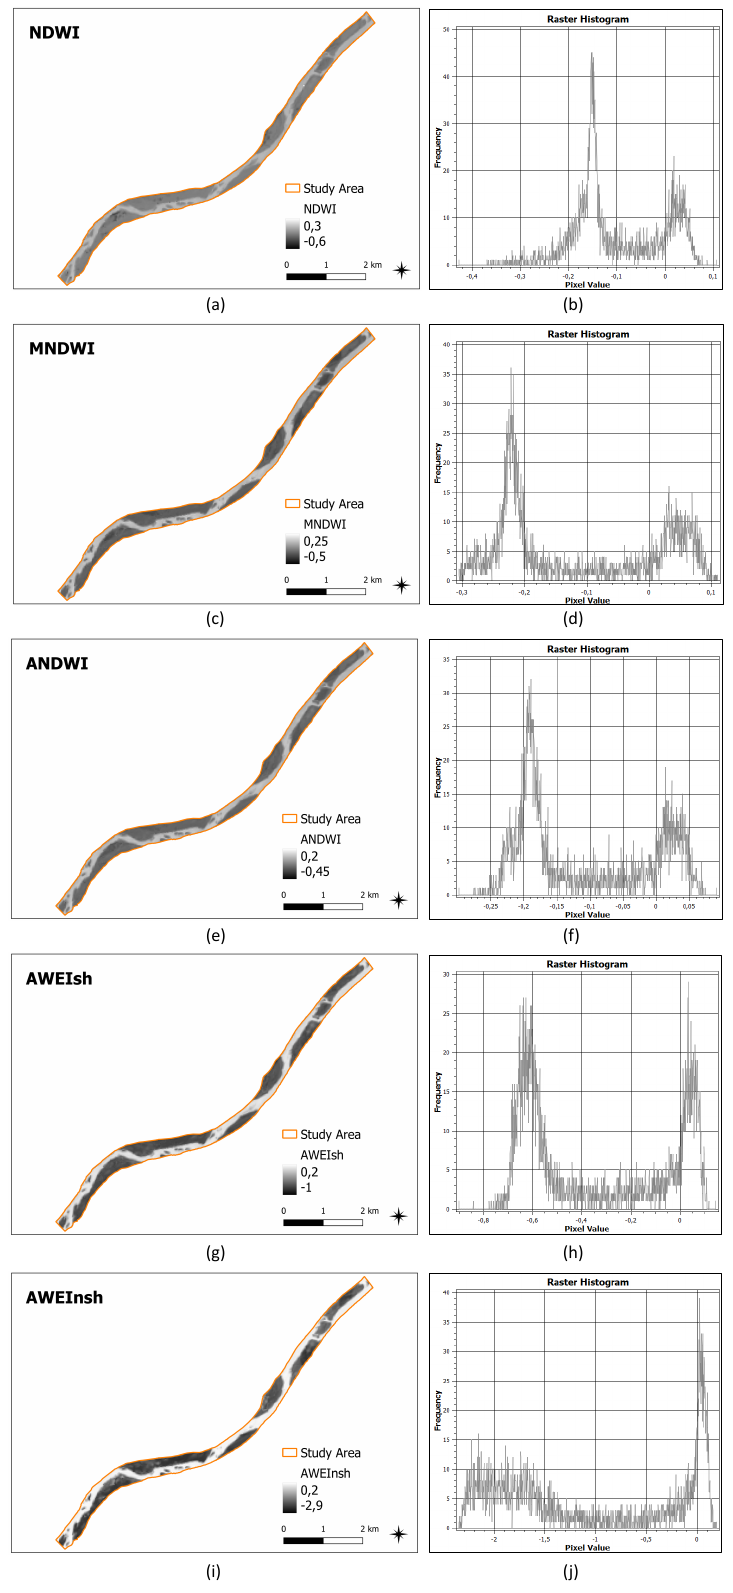
Figure 5. Using Landsat 9 imagery. ( a , c , e , g , i ) Spectral water indices maps of a segment of the Tagus River (Portugal) for NDWI, MNDWI, ANDWI, AWEIsh, and AWEInsh; the darker colors indicate non-water features. ( b , d , f , h , j ) Corresponding data histograms. The data spatial resolution is 30 m. The date of observation was 7 July